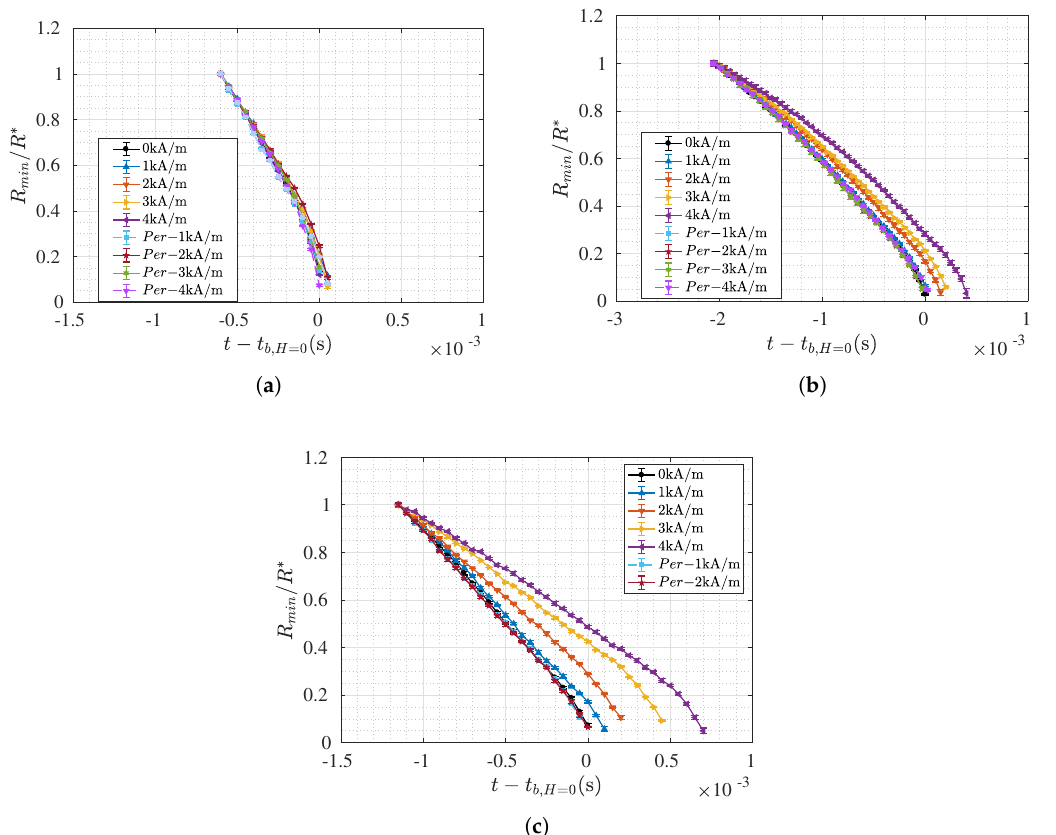
Figure 5. Time evolution of the normalised minimum radius ( R min / R ∗ ) under the application of an external magnetic field with different intensities and different orientations. Each plot corresponds to each oil-based ferrofluid, where Per referes to the perpendicular configuration.( a ) EMG-911, ( b ) EMG-909, ( c )